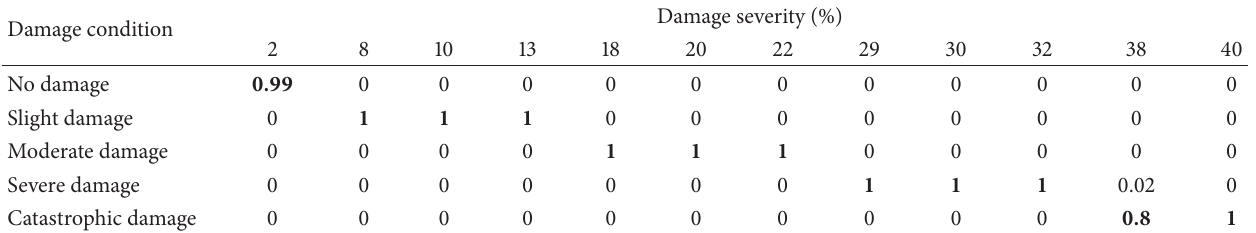
Table 7: Membership degree of test samples identified by fuzzy systems.